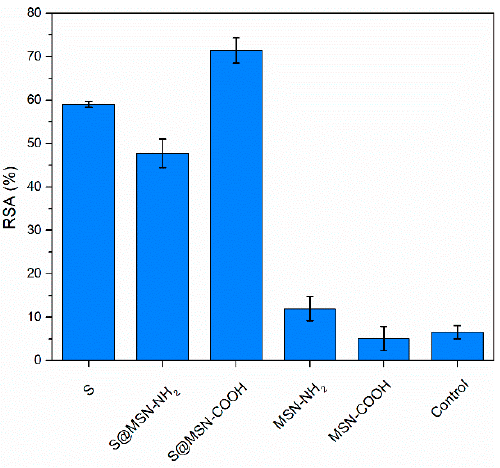
Figure 5. Radical scavenger activity of polyphenols-loaded MSN by the ABTS assay. Table 2. Antibacterial activity of free common sage extract and embedded in functionalized MSN.